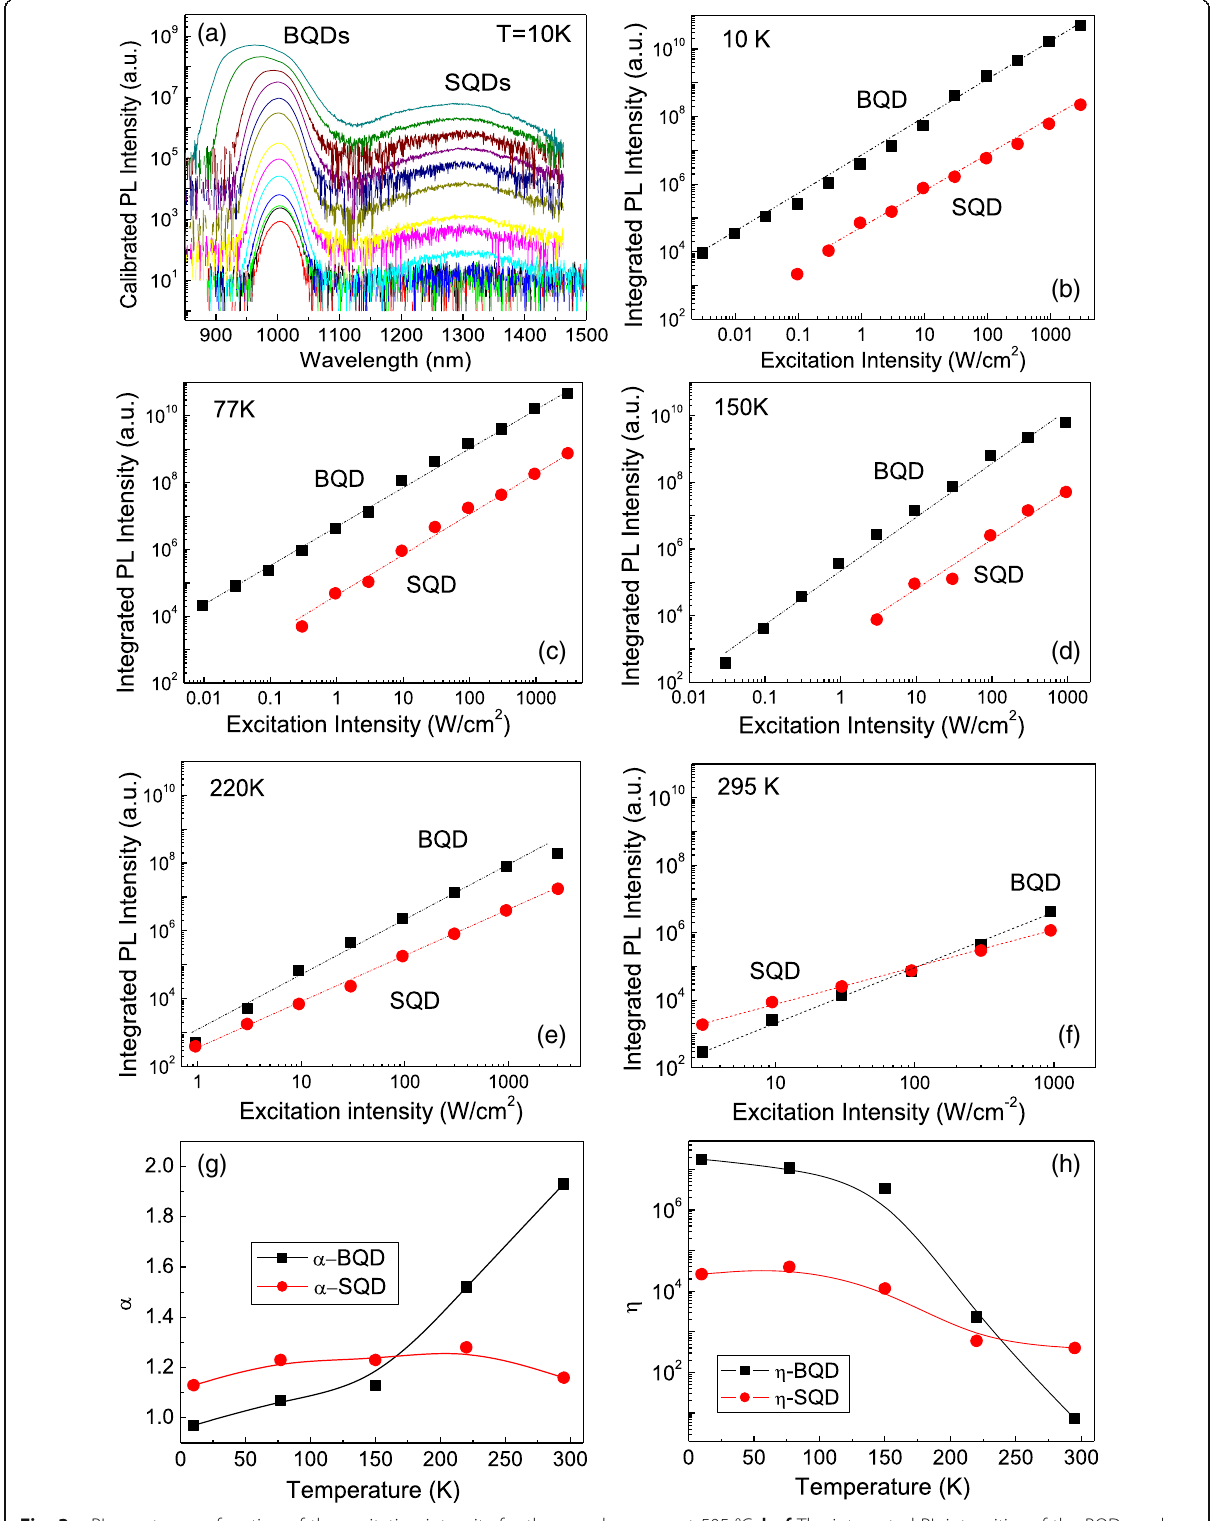
Fig. 3 a PL spectra as a function of the excitation intensity for the sample grown at 505 °C. b ~ f The integrated PL intensities of the BQDs and SQDs as functions of the excitation intensity at 10 K, 77 K, 150 K, 220 K, and 295 K respectively. g , h The power law parameters α and η for BQDs and SQDs at different temperature. Here, the lines are only